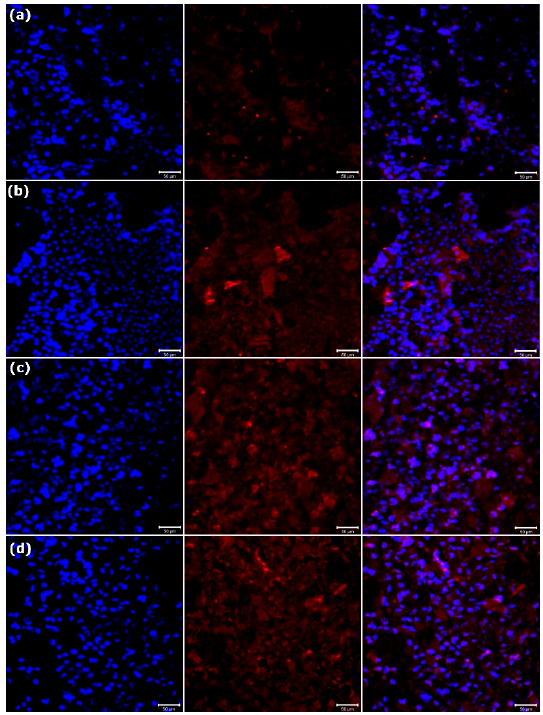
Figure 8. Immunofluorescence analysis of bone sialoprotein (BSP) on ( a ) PCL, ( b ) PCL–SrHANF (65), ( c ) PCL–SrHANF (130), and ( d ) PCL–SrHANF (195) after 14 days of culture. The MG63 osteoblast-like cells were stained with BSP ( red ), and the cell nuclei were stained with DAPI ( blue ). Scale bar = 50 µm.